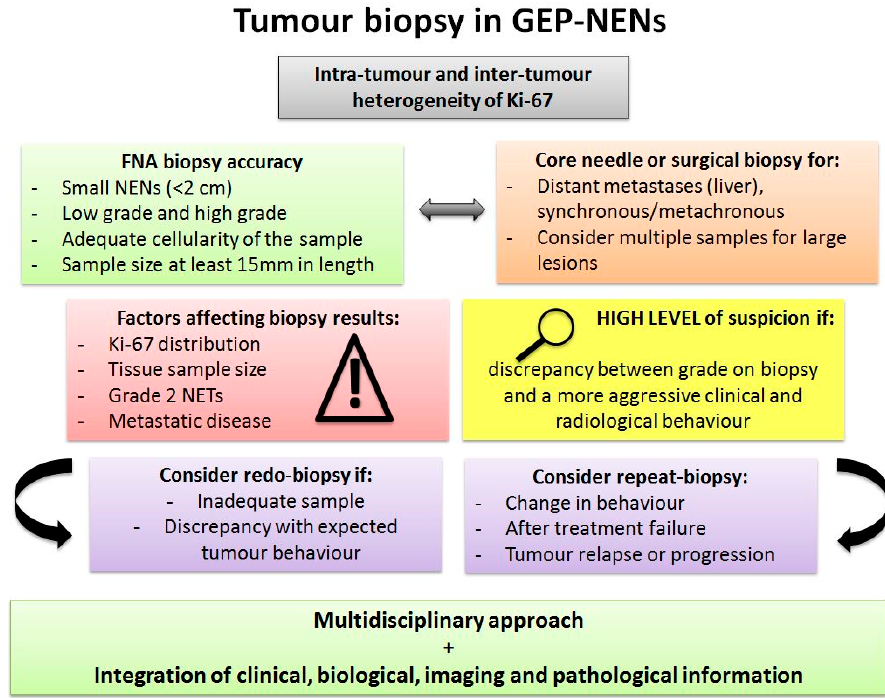
Figure 3. Tumour biopsy in GEP-NENs. Pitfalls and suggestions for tumour biopsy in GEP-NENs. Abbreviations: GEP: gastroenteropancreatic; FNA: fine-needle aspiration; NET: neuroendocrine tumour.